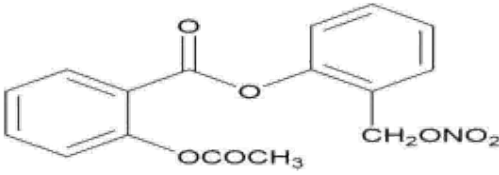
Figure 3. Nitric oxide aspirin (NO-Aspirin) In various clinical conditions,